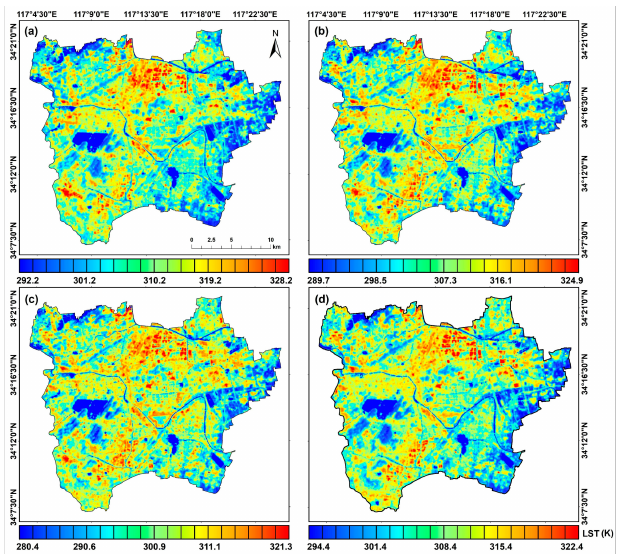
Figure 6. Land surface temperature inversion maps of ( a ) 1 May 2014, ( b ) 16 May 2017, ( c ) 3 May